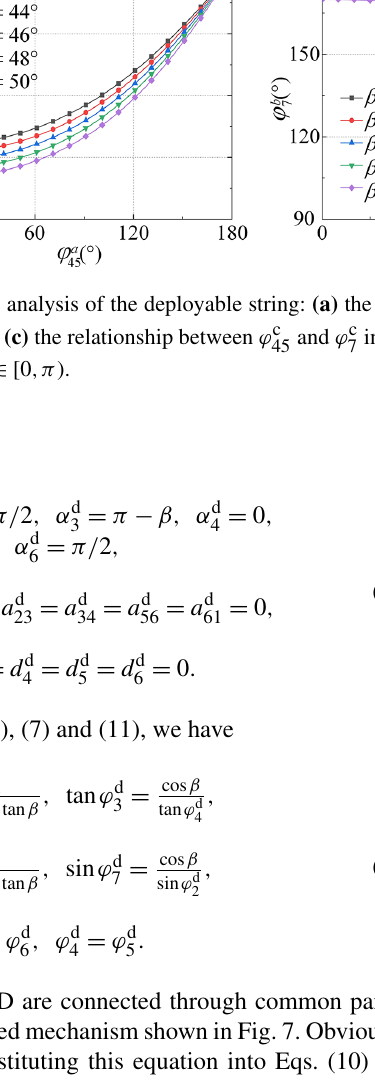
Figure 4. Three units with different parameters in the deployable string and their DH parameters: (a) U M -A, (b) U B -B, and (c) U B -C. ϕ k ( i = 1 ∼ 6, k = a, b, and c) denotes the dihedral angle between two panels connected by joint i in unit k . Specially, ϕ k between two CPs in unit k .